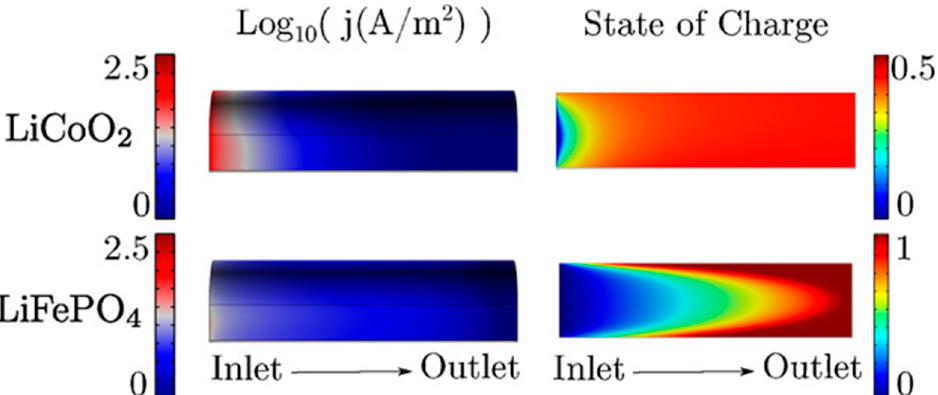
Figure 2. Comparison of the SOC and steady-state current density distributions along a flow channel in an SSFB, using LiCoO 2 and LiFePO 4 active particles [36].